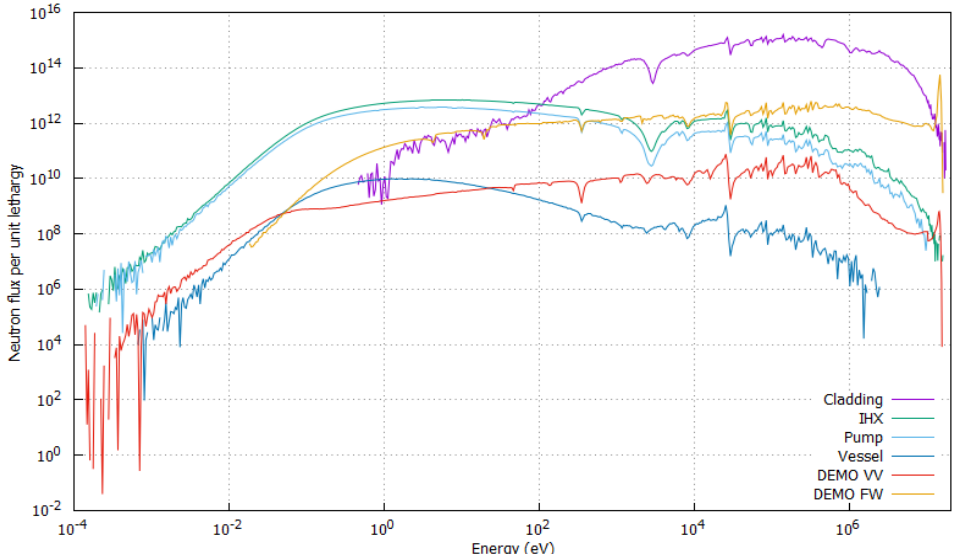
Figure 3. Comparison of Neutron Flux Spectra Within Key ESFR and DEMO Reactor